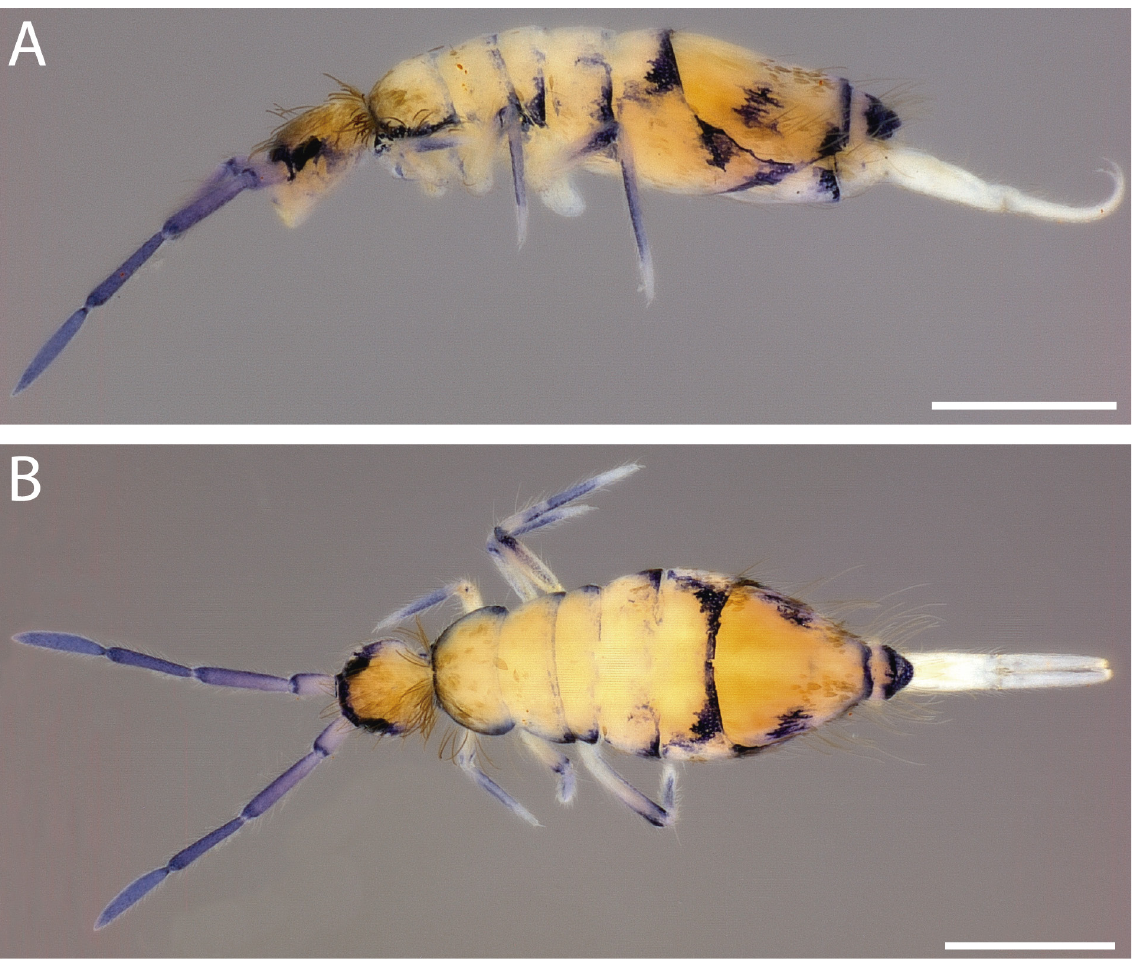
Fig. 2. Willowsia nigromaculata (Lubbock, 1873), habitus. A . Lateral view. B . Dorsal view. Scale bars: 0.5